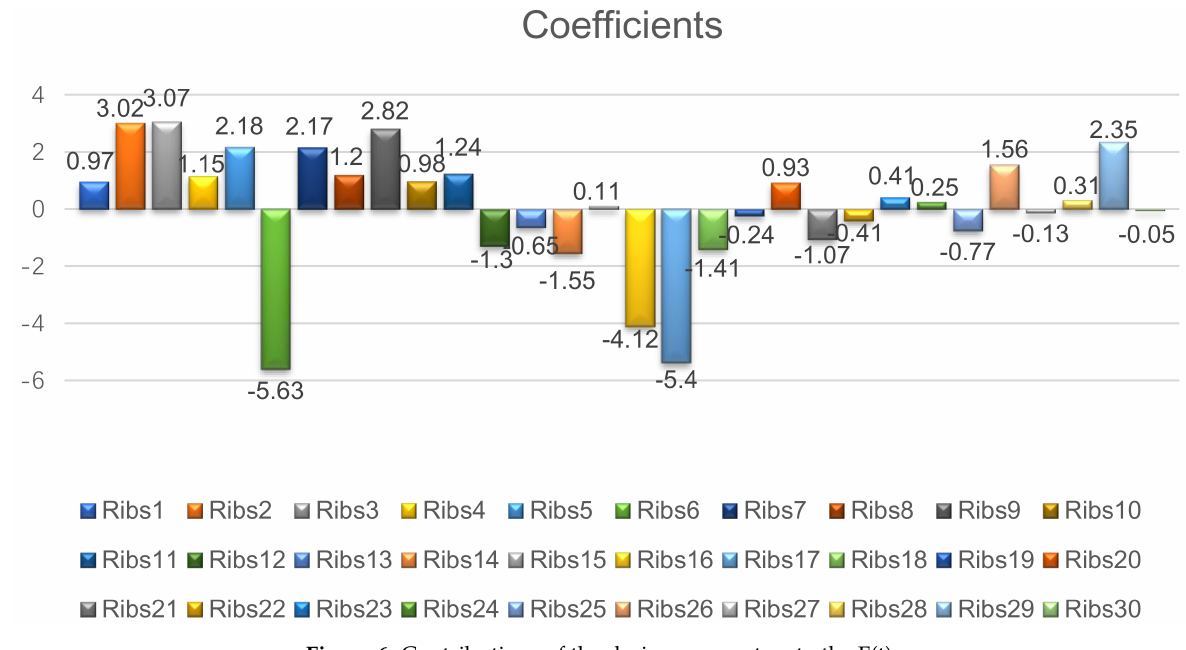
Figure 6. Contributions of the design parameters to the F(t).